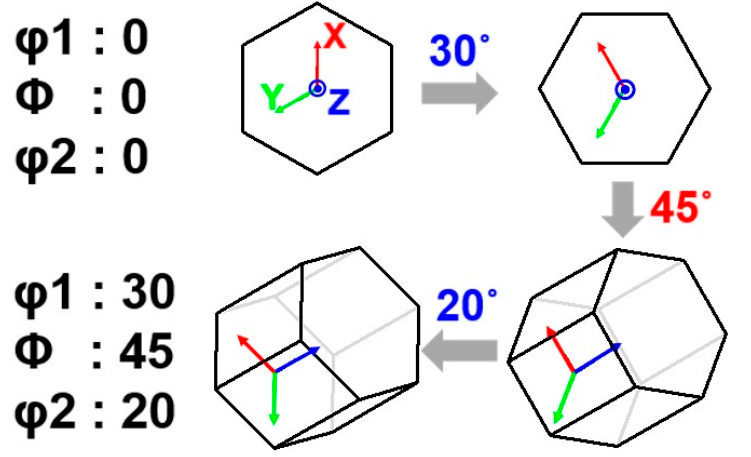
Figure 1. A crystal with Euler angles (0°, 0°, 0°) rotated to Euler angles (30°, 45°,